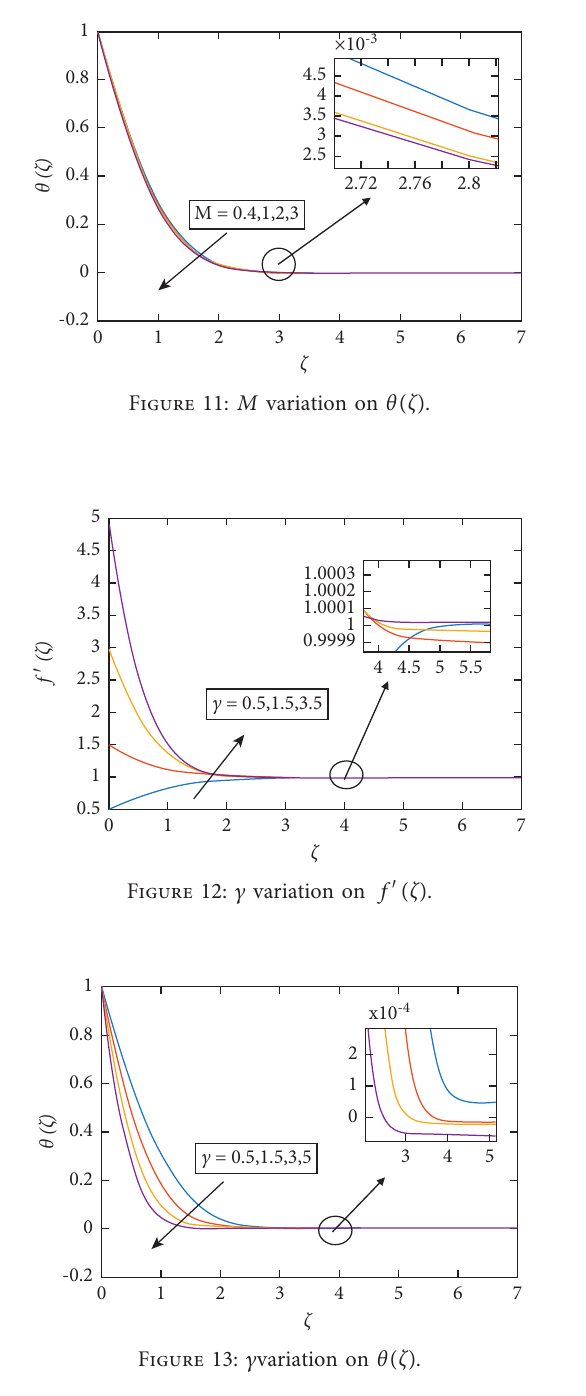
Figure 14 demonstrates effect